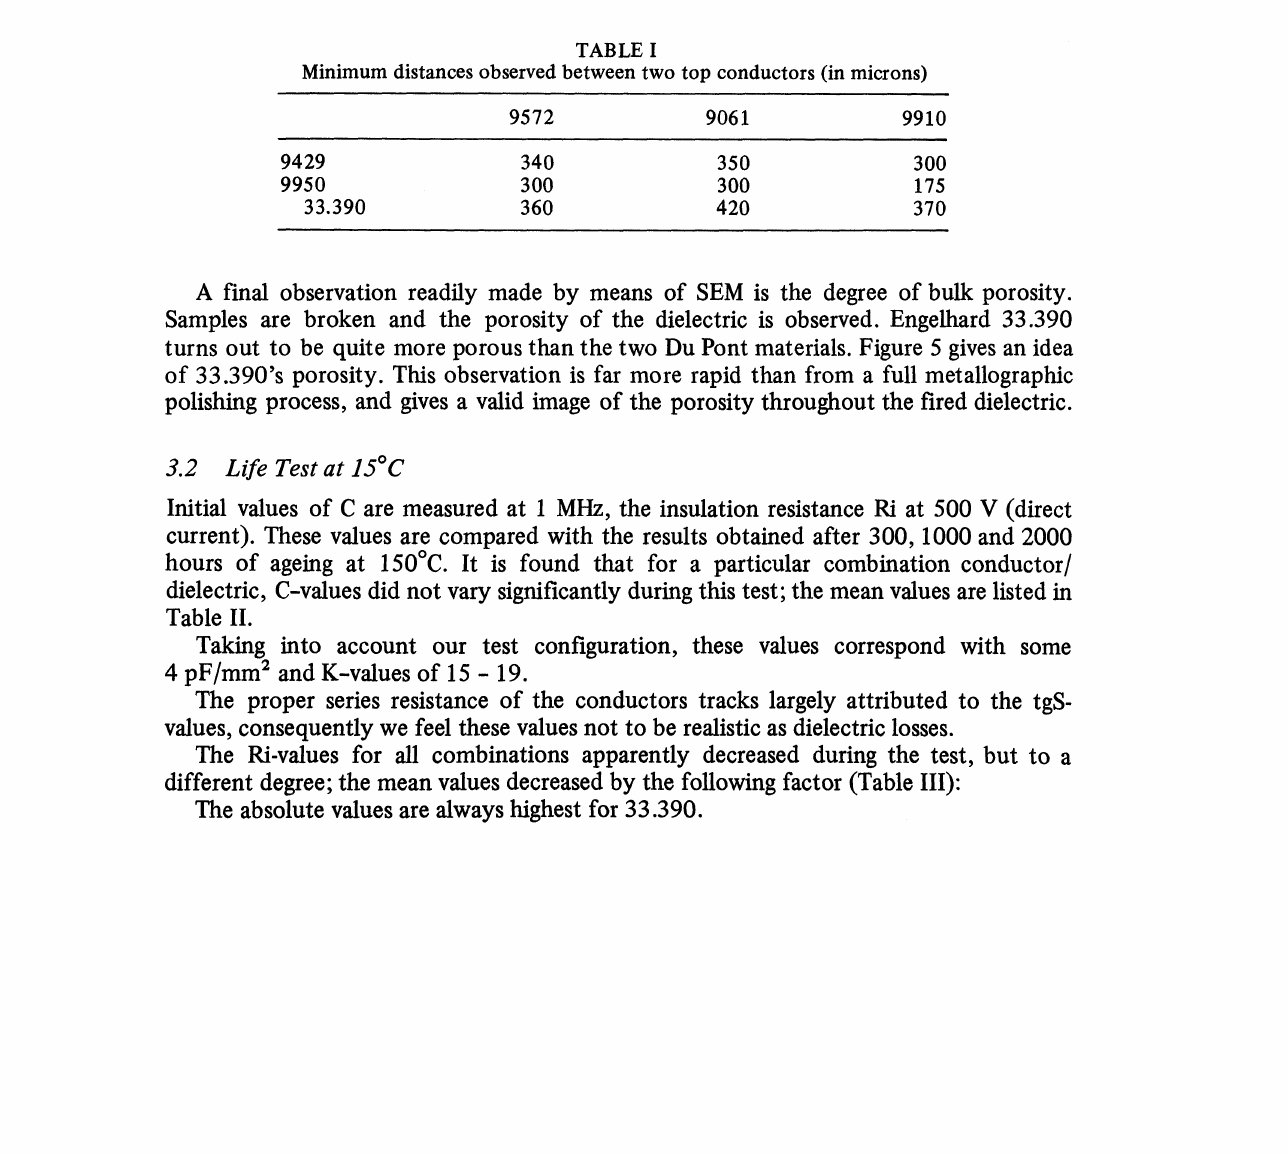
FIGURE 4 Flow behaviour on Eng. 33.390, Secondary electron image (25 kV). TABLE Minimum distances observed between two top conductors (in